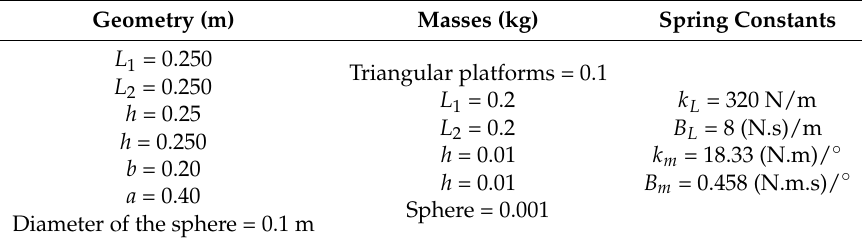
Table 1. Physical characteristics of the sensor flow